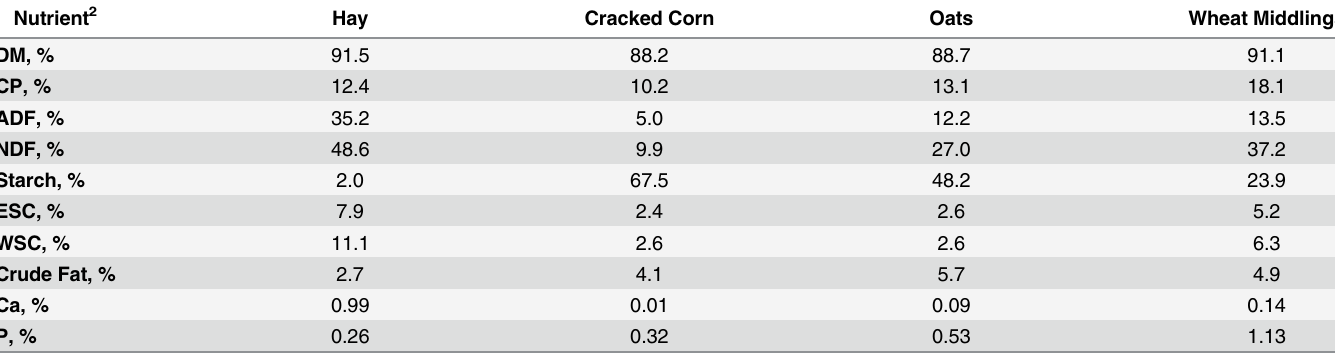
Table 1. Chemical composition hay, corn, oats and wheat middlings 1